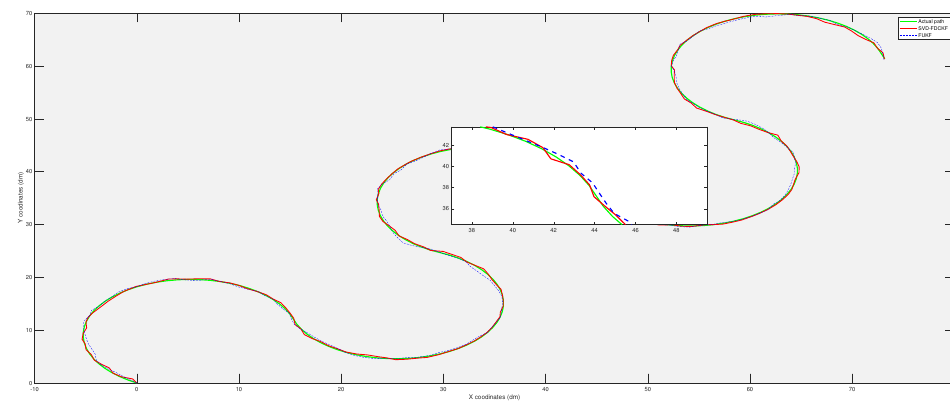
Figure 9. The comparison of the real trajectory of the mobile robot with the SVD-FDCKF estimated trajectory and FUKF estimated trajectory.